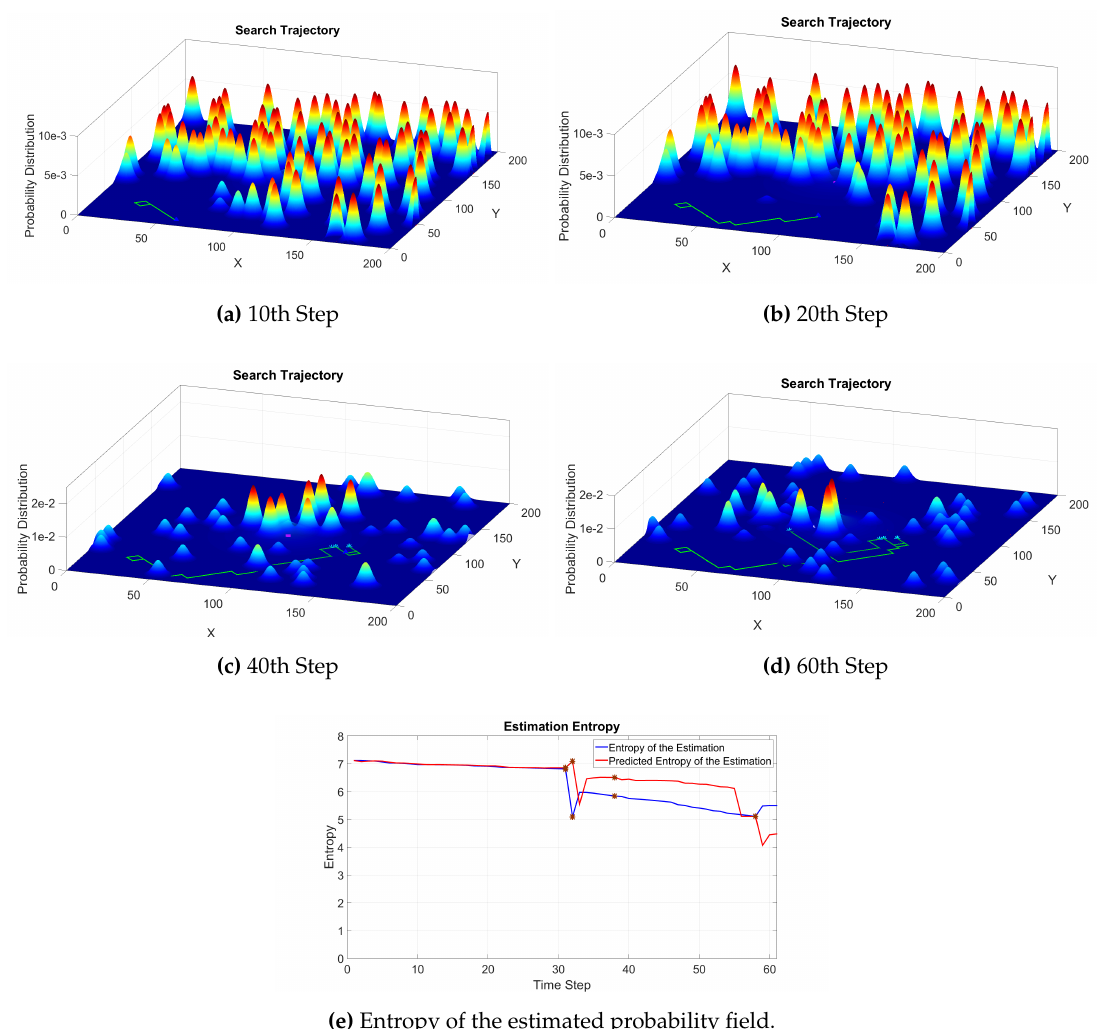
Figure 5. ( a – d ) The trajectory for a single robot searching for the source a of chemical dispersion. The probability field is spanned with 100 Gaussian functions each with a weight adjusted by each observation. ( e ) Variation of the entropy for the estimated probability distribution. The sensing capability of the robot is assumed to be independent of the bearing of the robot. The red plot indicates the predicted change in entropy for the next move while the blue plot is the actual entropy of the estimation after integrating the